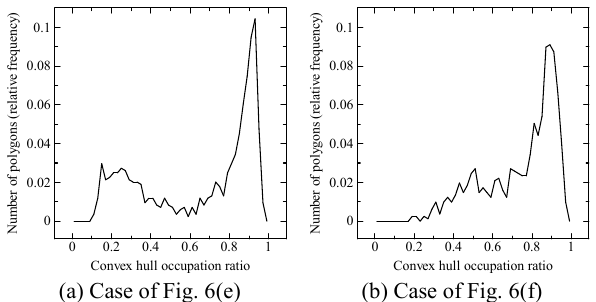
(b) Case of Fig. 6(f) (a) Case of Fig. Figure 7. Comparison of convex hull occupation ratio of stone polygons by relative frequency distribution